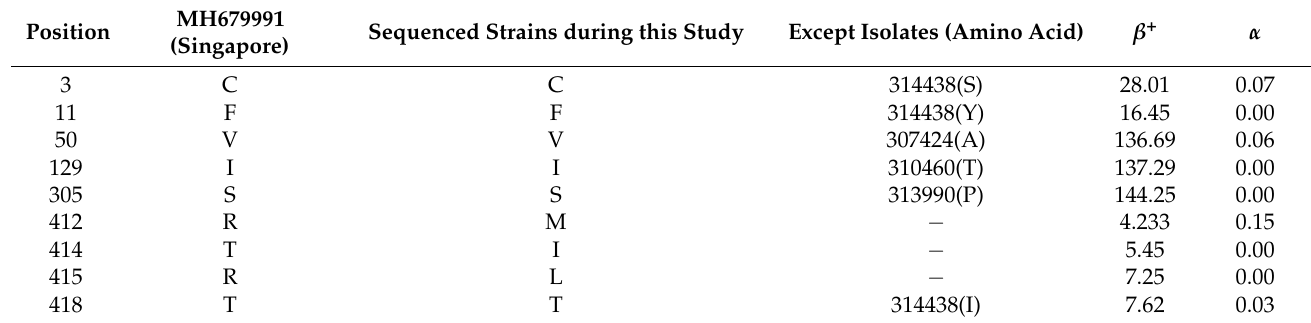
Table 2. Observed codon site substitutions including MH679991 from Singapore. Column 4, Except Isolates (Amino Acid), indicates the sequenced isolates during this study, which show a different amino acid at a given position compared to the remaining; the observed amino acid at this position is indicated in parenthesis. Although not significant at a p -value > 0.05, the mixed effects model of evolution (MEME) suggests that most codon sites had β + > α , with the exception of codon site